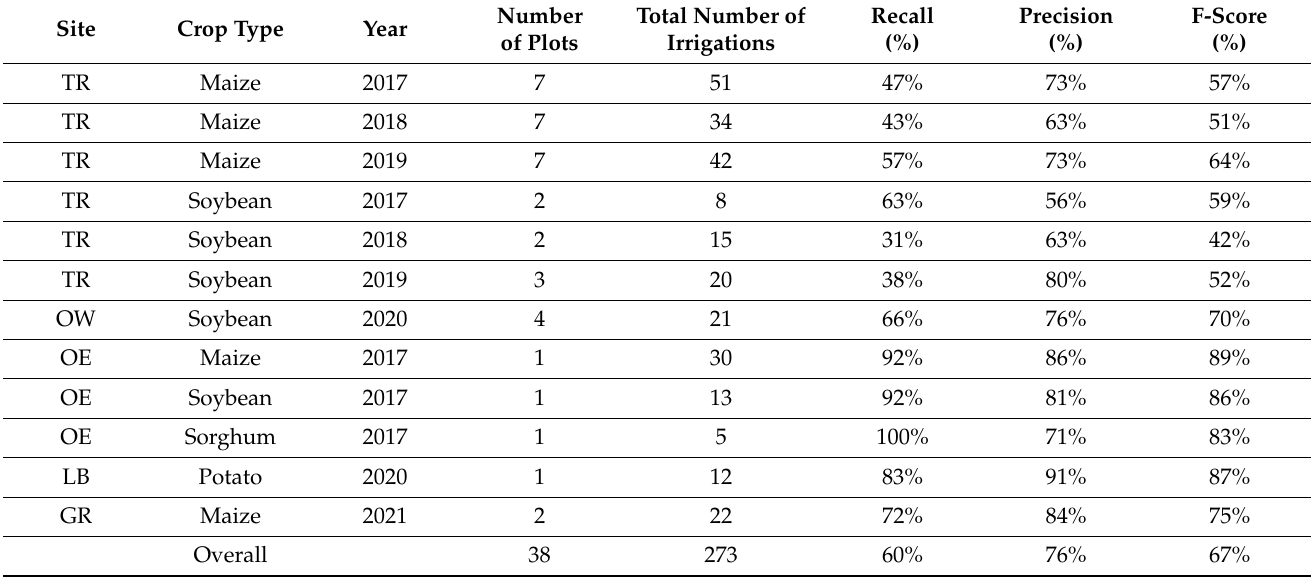
Table 3. Recall, precision and F-score per site, year and crop